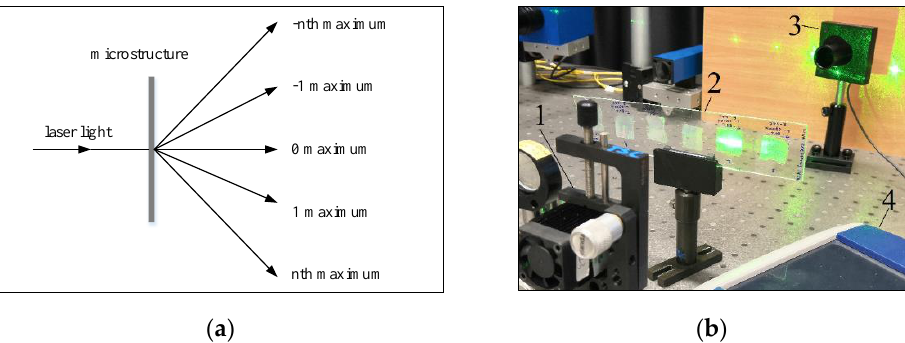
Figure 3. Diffraction efficiency measurements: ( a ) structural image of the diffraction peaks; ( b ) measurement equipment: 1 — laser, 2 — grid, 3 — photodiode, 4 — a visual display of results.